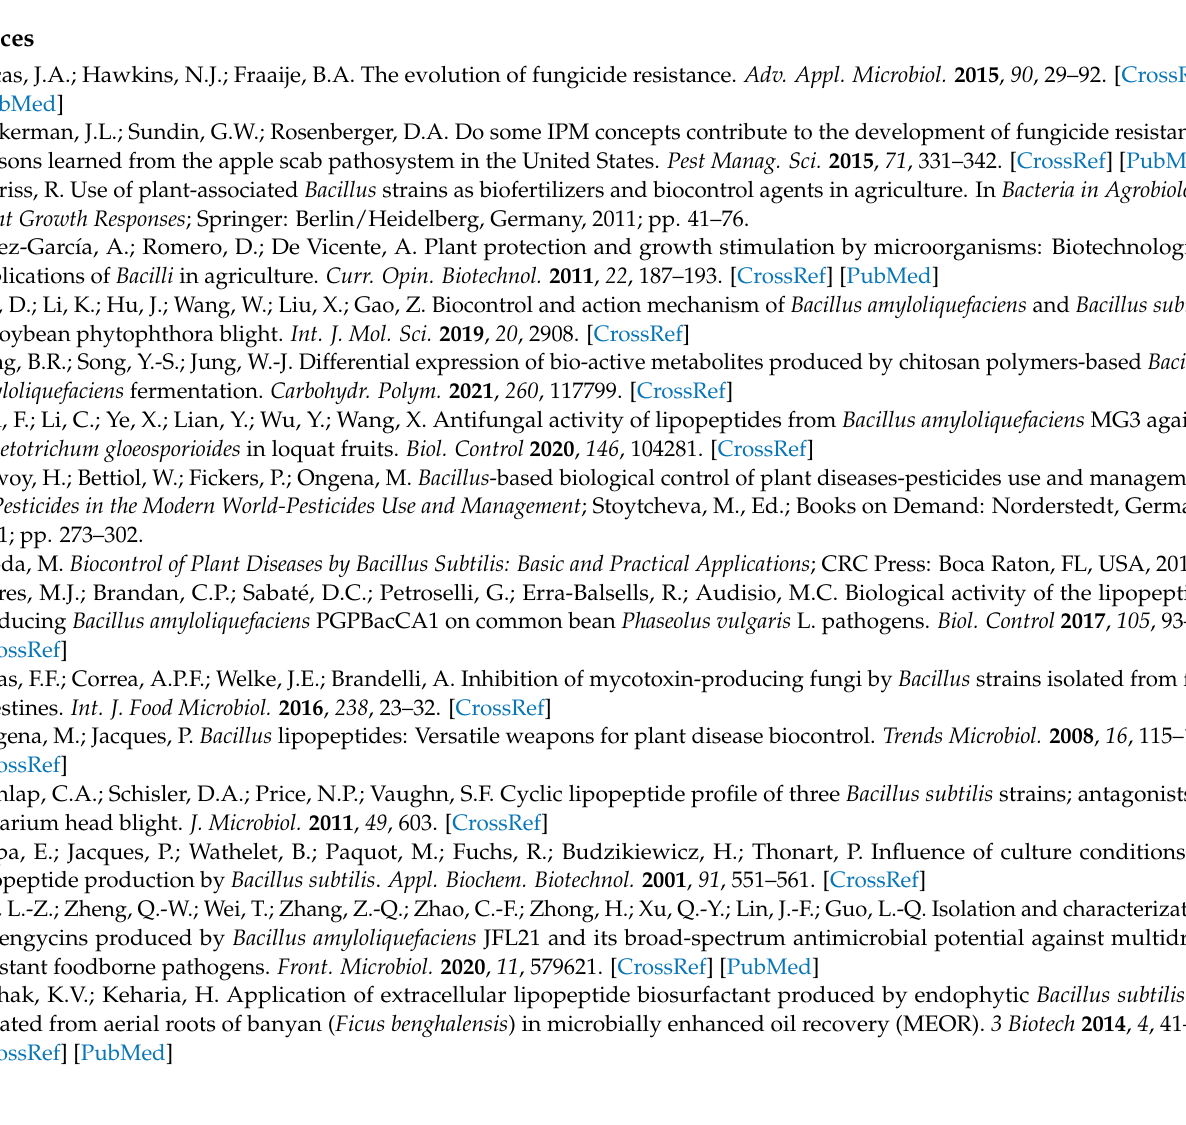
Figure S2: Molecular ion peaks and mass spectra of iturin of Bs KB21, Figure S3: Molecular ion peaks and mass spectra of fengycin of Bs KB21, Table S1: MRM transition parameters of analytes in